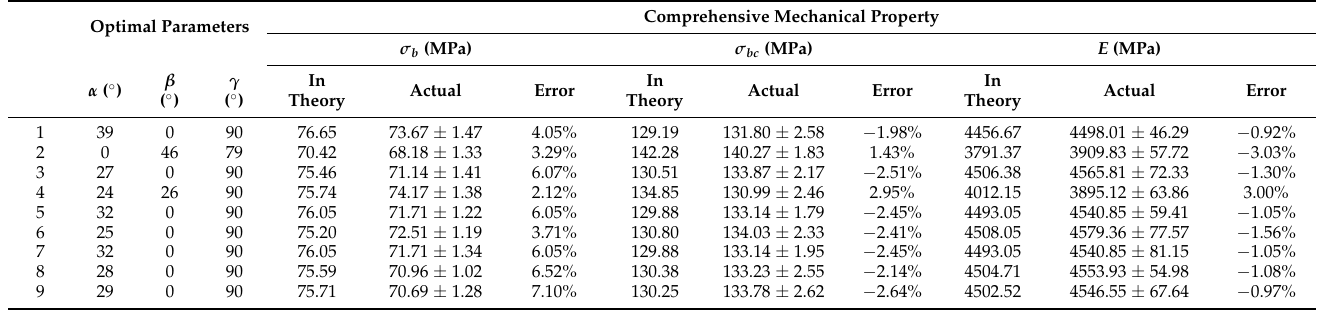
Table 9. Comparisons of optimal comprehensive mechanical property in theory with that in actuality.